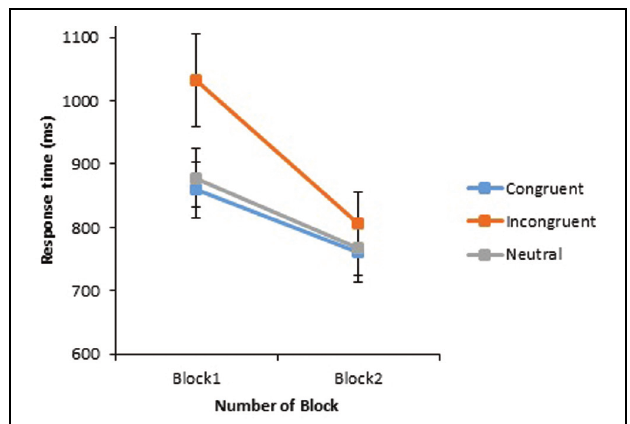
FIGURE 2 | Experiment 1: mean response times (in milliseconds) of correct judgments to critical word pairs across Block 1 and Block 2. The vertical axis begins at 600 ms while error bars indicate the 95% confidence interval.